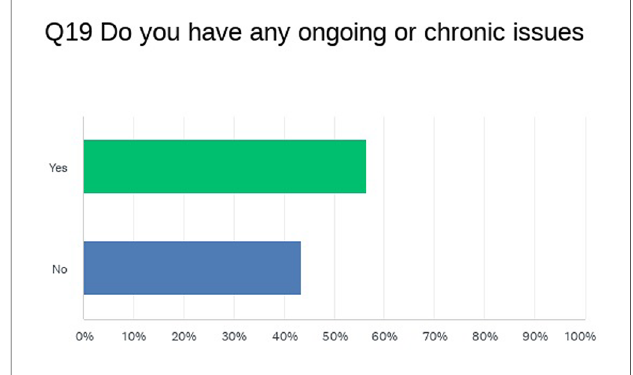
FIGURE 1 Analyzed data from CDH UK transition from child to adult services survey question